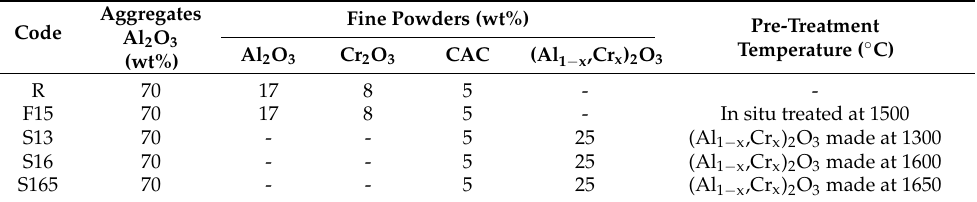
Table 2. The formulation of fine powders undergoing reaction within castables (30wt% of total).